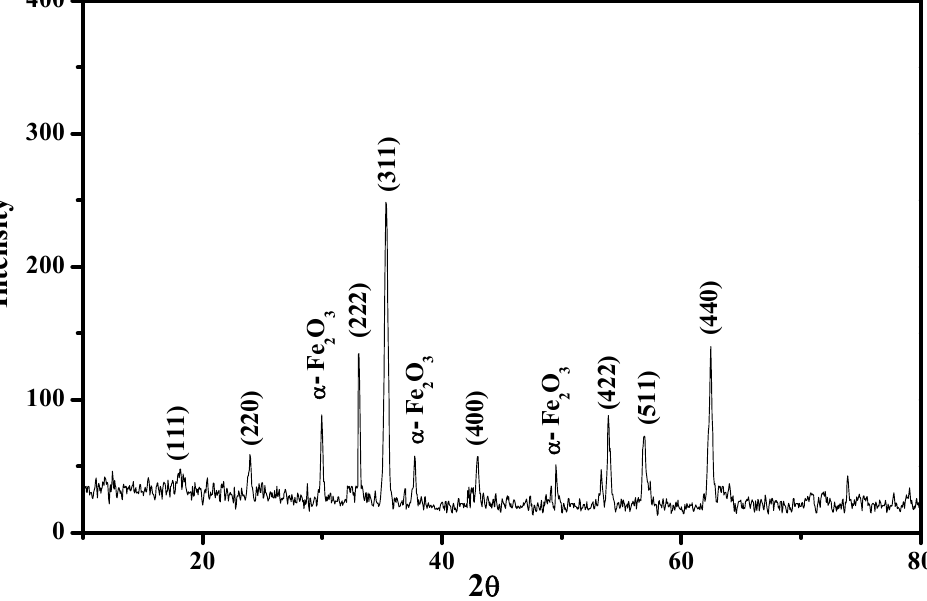
ff raction spectra of CoFe